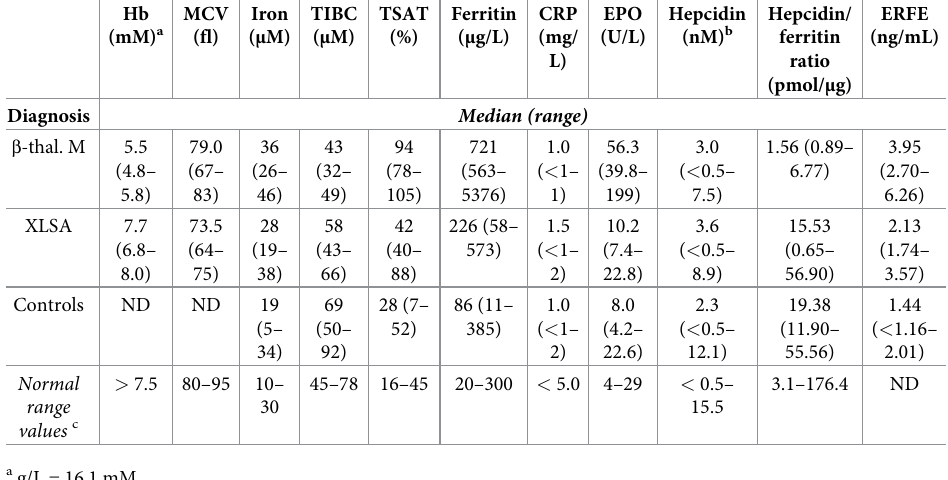
Table 5. Summary of patient and control characteristics and hematological